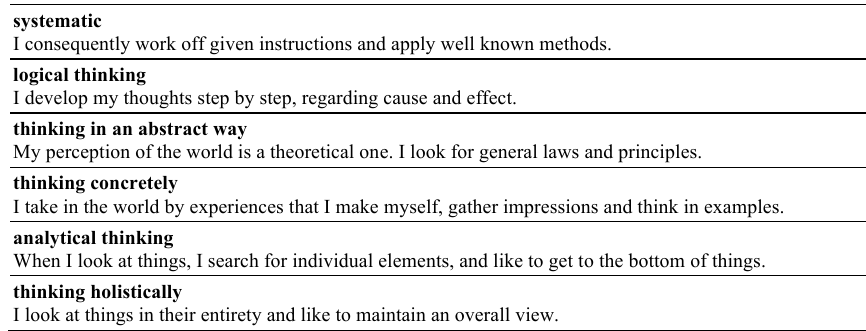
Table 2. Selection of relevant competences [1] and their descriptions